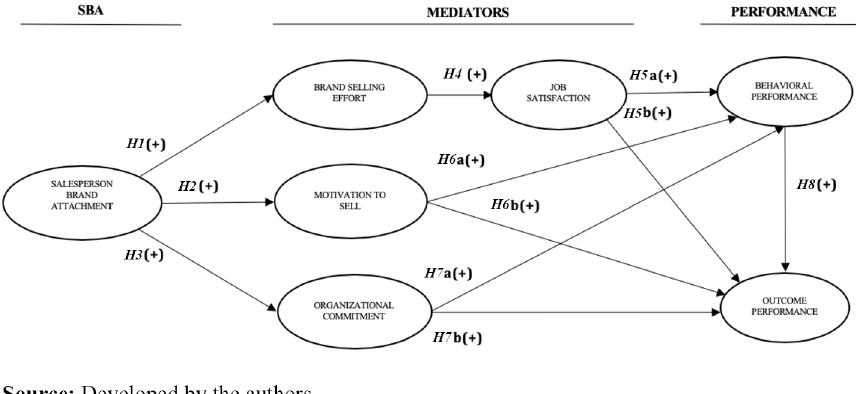
Figure 1. Conceptual model and research